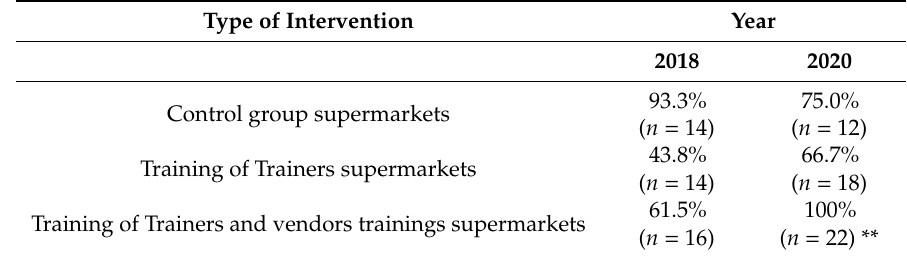
Table 3. Visibility of warning signs in supermarkets visited in 2018 and in 2020 for all the intervention